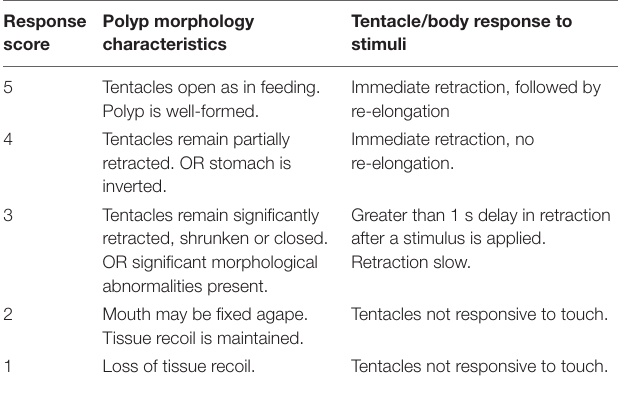
TABLE 1 | Response scores with corresponding polyp morphology and degree of tentacle and body response. Response